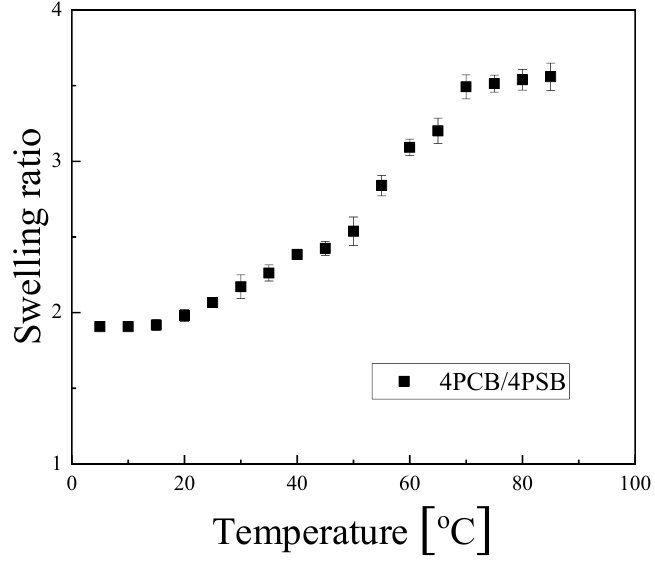
Figure 2. Temperature responsiveness of PCB/PSB IPN hydrogel studied in distilled water (pH = 6.4): swelling for 8 h was performed at a defined temperature within the temperature range from 5 to 90 °C.